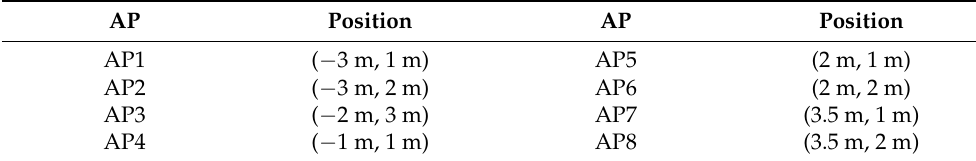
Table 3. The specific positions of